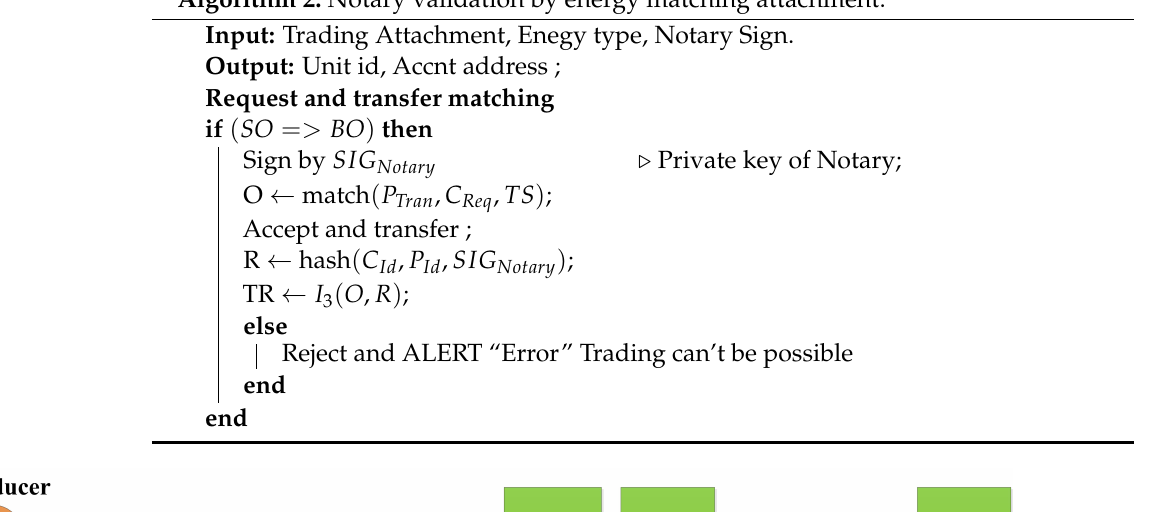
Algorithm 2: Notary validation by energy matching attachment.